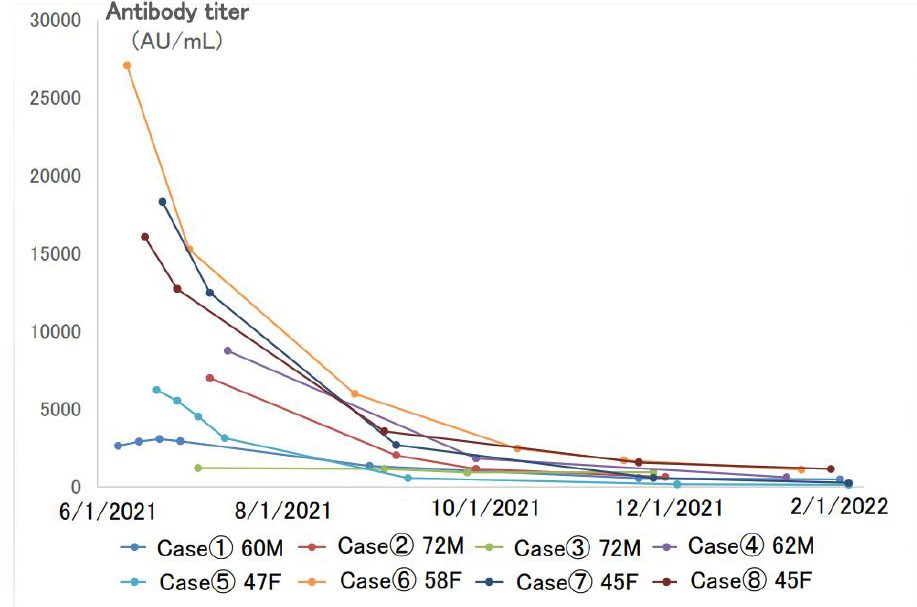
Figure 3. Longitudinal changes of SARS-CoV-2 antibodies in eight cases with multiple follow-ups after the second dose of the vaccine.